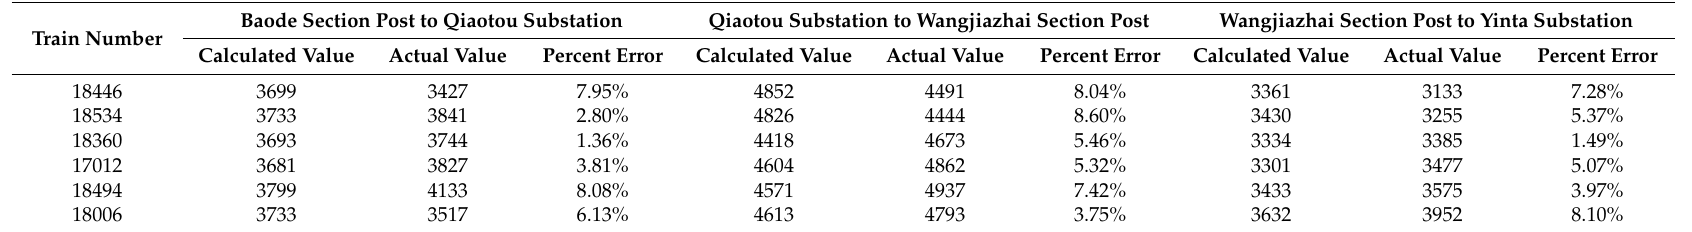
Table 6. Verification results of energy consumption of DC trains in the uphill section.